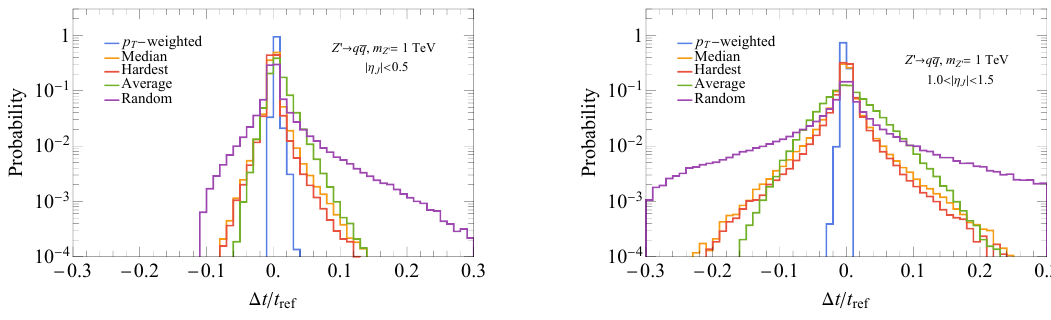
Figure 8 . The relative time difference distribution in prompt jets for | η J | < 0 . 5 (left) and for 1 . 0 < | η 1 . 5 J | <